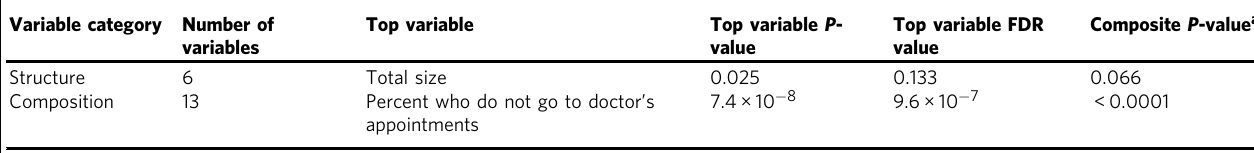
Table 3 Relationship of the composite categories of network variables to MSRS in all participants Variable category Number of